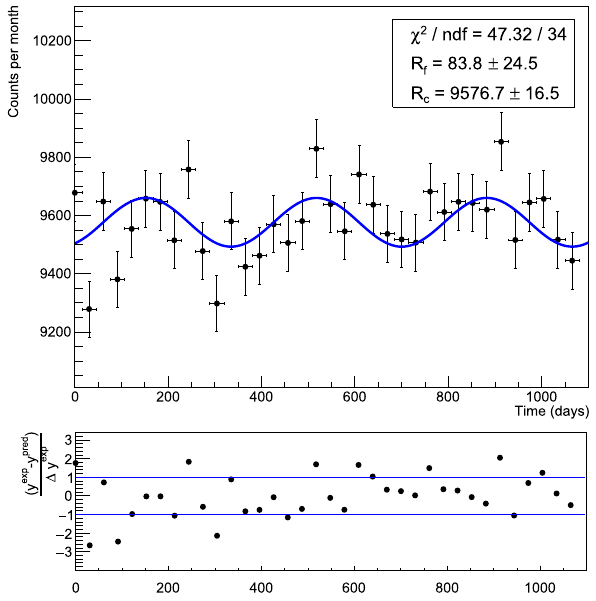
Fig. 2 Simulatedfluctuationsinsignal+backgroundmodel,with R b = 1 cpd/kg/keV, R m = 0 . 012 cpd/kg/keV, and R 0 = 0 . 6